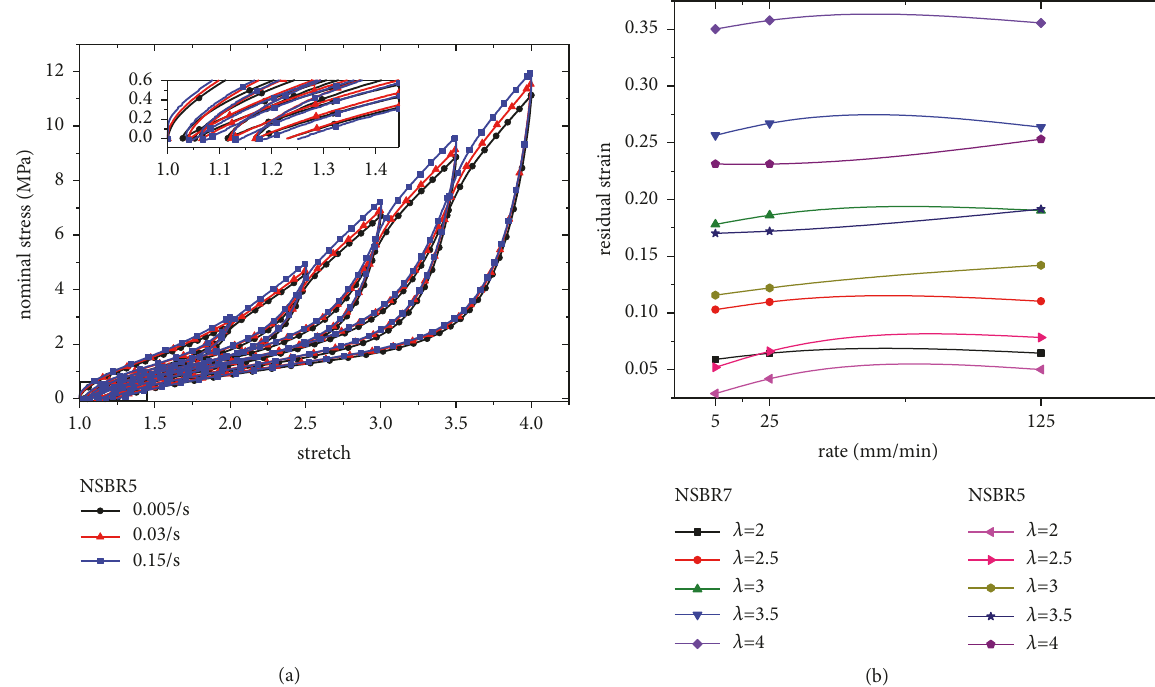
Figure 2: Curves of the residual strain and rate for the rubber: (a) the experimental results of NSBR5 for the Mullins effect at different rates of 0.005/s, 0.03/s, and 0.15/s and (b) the residual strain and rate of NSBR5 and NSBR7.